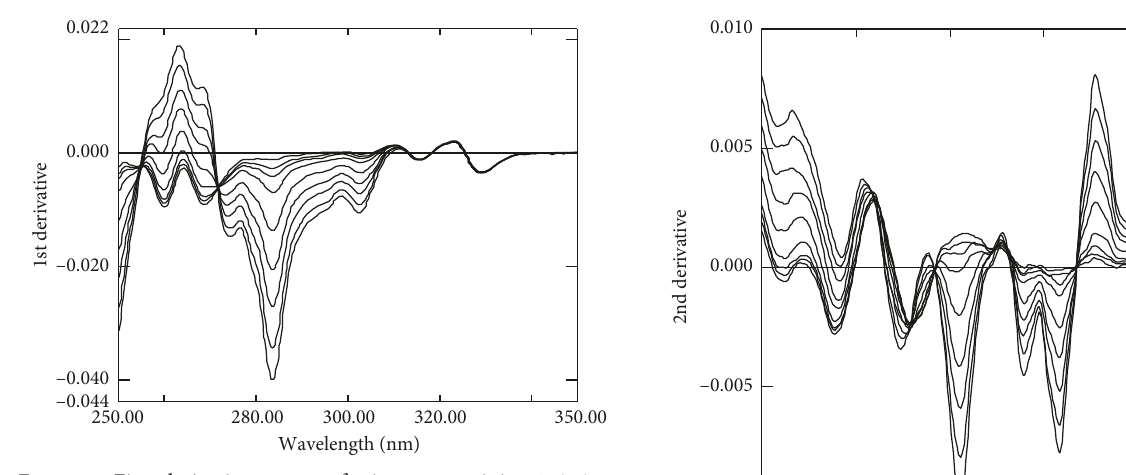
Figure 5: First derivative spectra of mixture containing 1, 2, 3, 5, 10, 15, 20, 25, and 30 μ g · mL − 1 pyriproxyfen and 3.0 μ g · mL − 1 chlorothalonil.